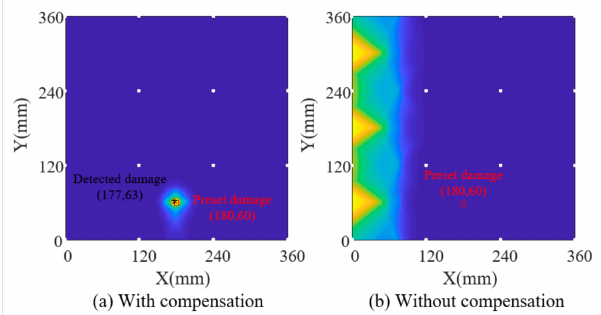
Figure 7. Damage identification results of simulation model 1.